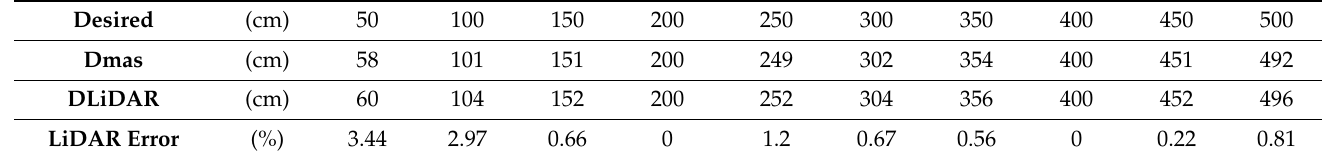
Table 4. Distance measurements with ambient light intensity of 265 lux (daylight) and a white target.